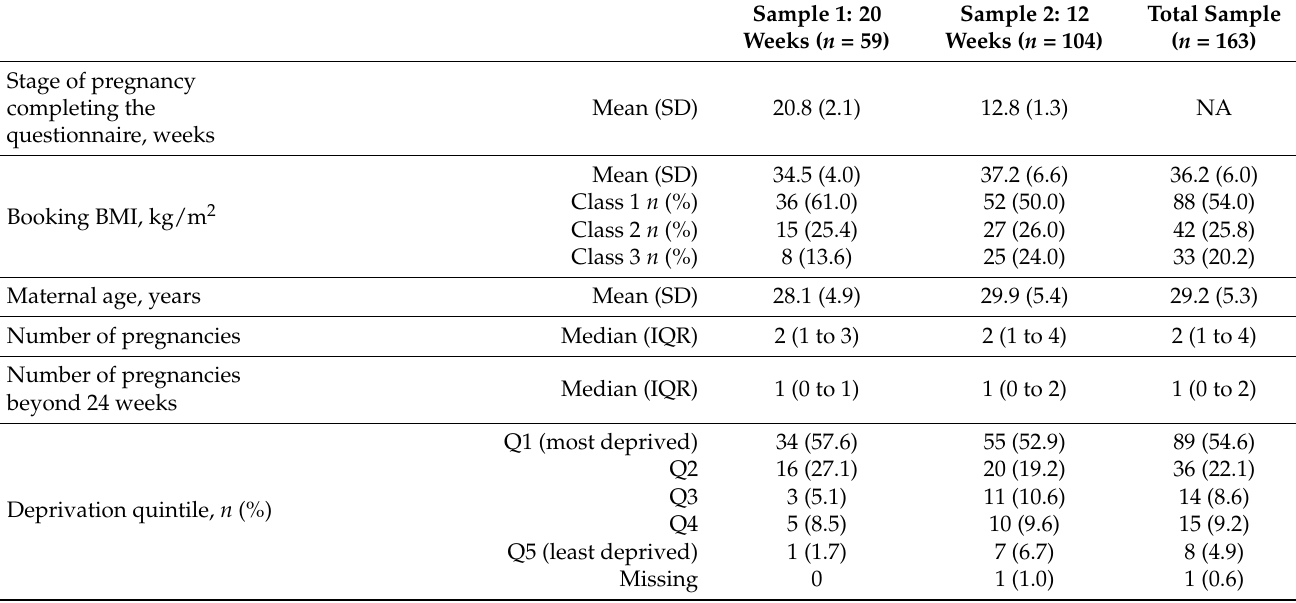
Table 1. GLOWING participant socio-demographic